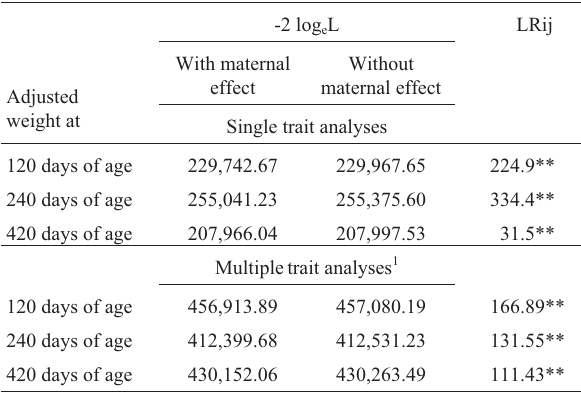
tance of this effect for weights at older ages. Table 2 - Values of minus twice the natural logarithm of the likelihood function (-2 log e L) and the likelihood ratio (LRij) test for the adjusted weights at 120, 240 and 420 days of age.